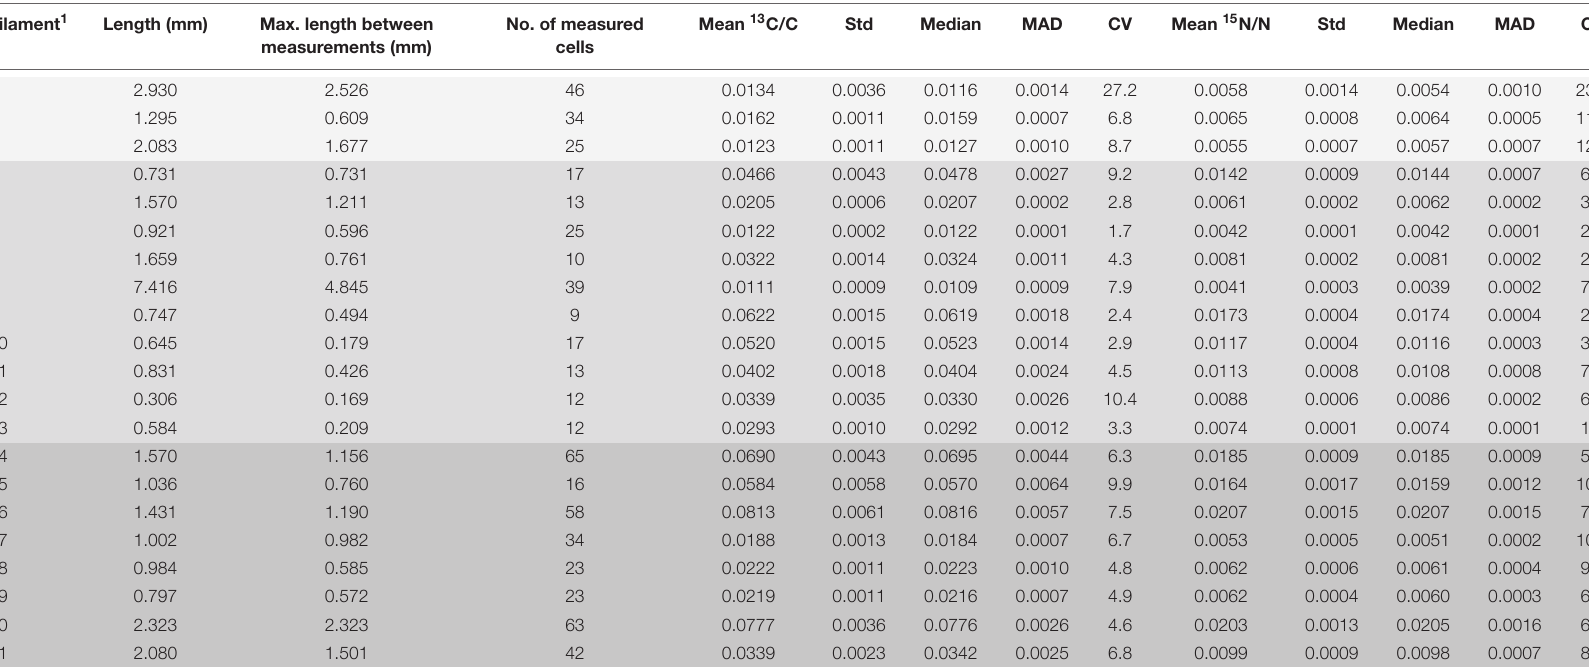
TABLE 1 | Cable bacteria filaments examined with nanoSIMS at multiple areas along the length: measured length, maximum length between measurements, number of measured cells and the mean 13 C and 15 N atom ratios and their corresponding standard deviations, the median values, mean absolute deviation (MAD) and coefficient of variation (CV). Differently shaded rows correspond to different zones and cores from which the analyzed filaments were retrieved (see table footnote